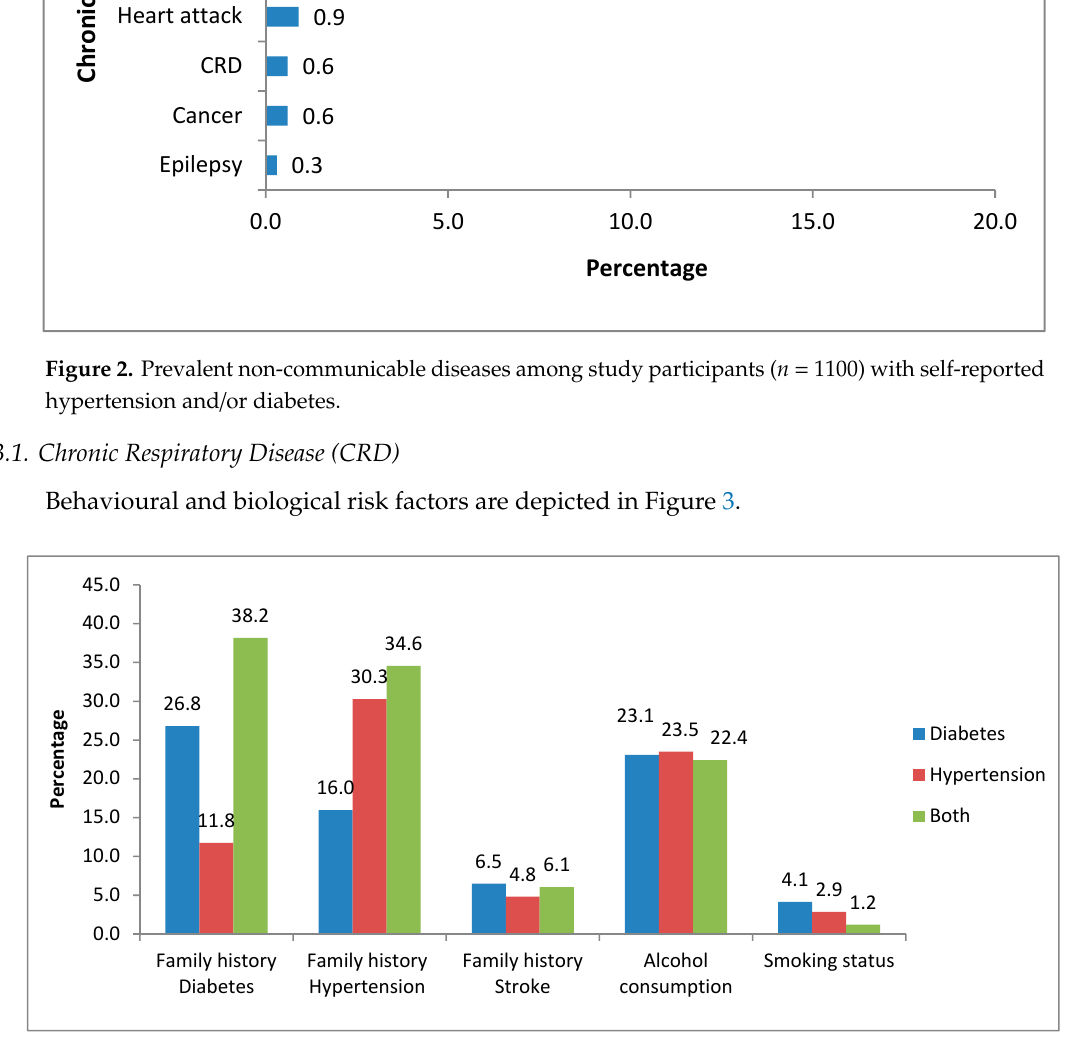
Figure 3. Proportion of respondents reporting selected behavioural and biological risk factors for non-communicable diseases.